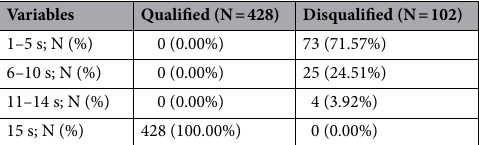
Table 2. Distribution of the duration for which individual sustained 9G exposure. N